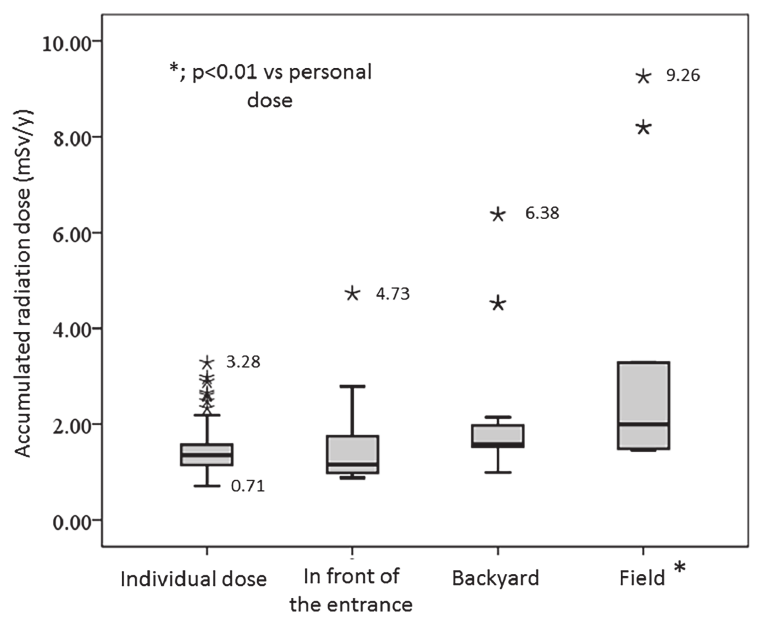
Fig 4. Cumulative individual doses, cumulative ambient doses in front of the entrance, in the backyard, and field around the